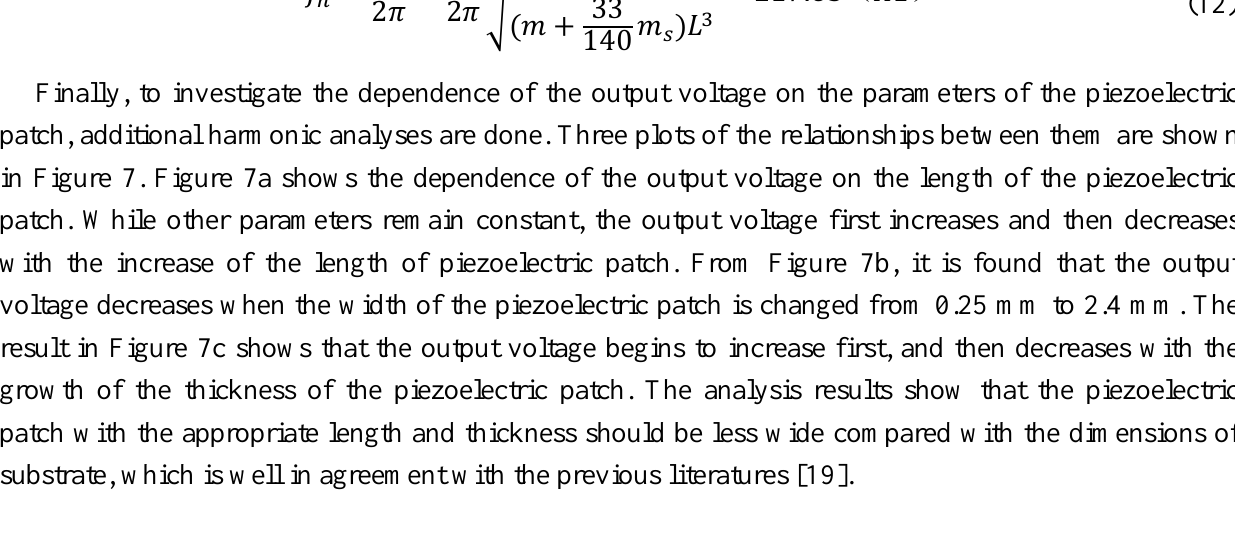
Figure 7. Output voltage versus piezoelectric patch dimensions. ( a ) Patch length. ( b ) Patch width. ( c ) Patch